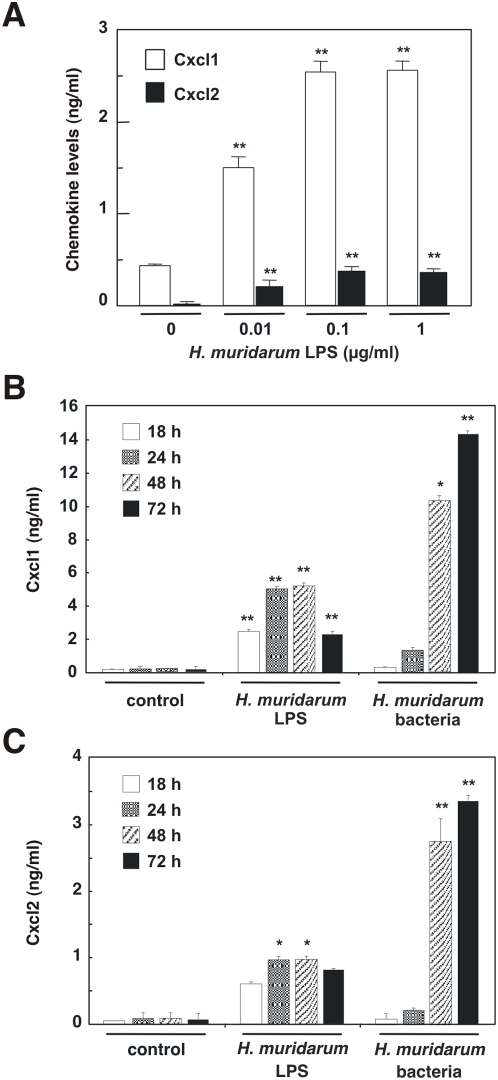

H. muridarum induces CXC chemokine production in m-ICcl2 cells by LPS-dependent and -independent mechanisms.m-ICcl2 cells were either left unstimulated (control) or stimulated with purified H. muridarum LPS or live H. muridarum ATCC49282 bacteria. The levels of secreted (A) Cxcl1 and Cxcl2 in the culture supernatants of cells stimulated for 48 h with different concentrations of H. muridarum LPS. Comparison of (B) Cxcl1 and (C) Cxcl2 levels in culture supernatants of cells stimulated for the indicated times with either 0.1 µg/ml H. muridarum ATCC49282 LPS or live H. muridarum ATCC49282 bacteria. Data correspond to the mean±SD (triplicate determinations) and are representative of three independent experiments. Statistical differences were observed between Cxcl1 or Cxcl2 levels following bacterial stimulation compared to control cells (*, P = 0.0002; **, P<0.0001).